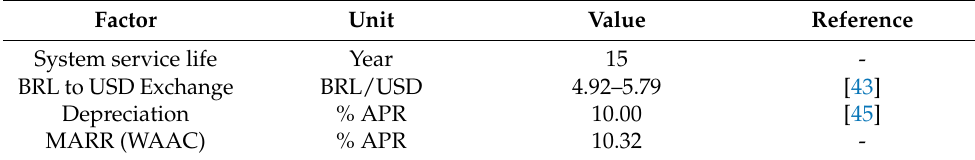
Table 7. Complementary data for the economic feasibility study of the power system.